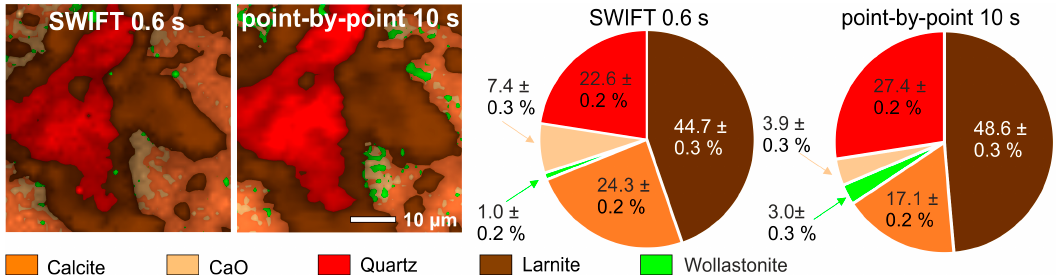
Figure 3. Comparison between the fast scanning mode (SWIFT © mode) with 0.6 s per spectrum (recording time 50 min) and the point-by-point method with 1 s times 10 accumulation per spectrum (recording time 8 h 43 min). Note that the acquisition time has to be faster than the mineral reactions under investigation. Grain boundaries are slightly different when using the fast scanning mode that is negligible when comparing only images recorded with the same acquisition time. A semi-quantitative statement is still